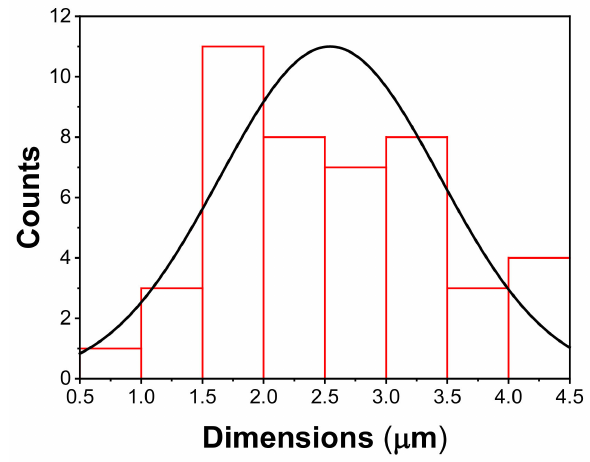
Figure 4. Histogram of dimensions of the notable cubes in µ m from Figure 3A.